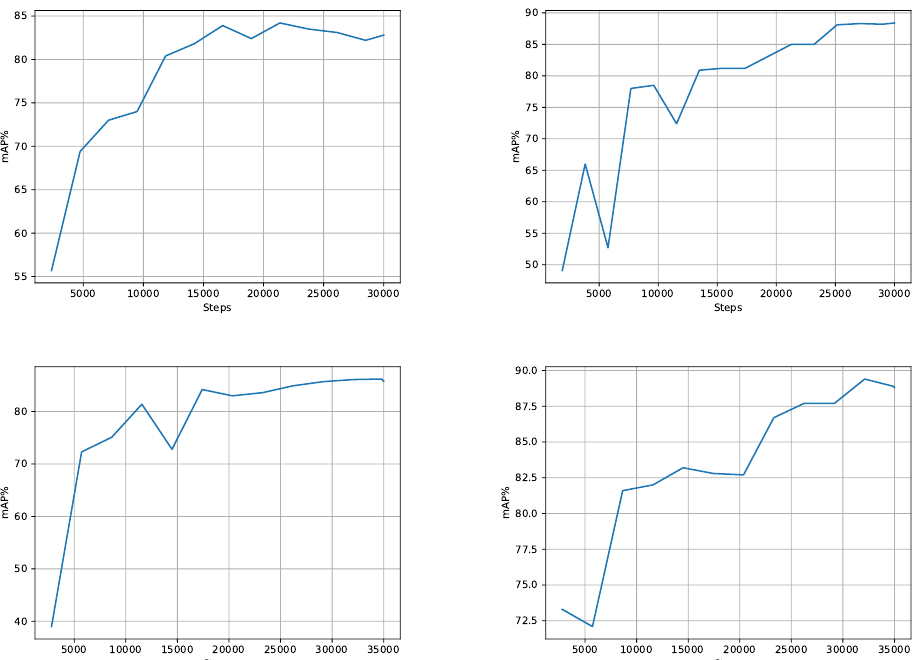
Figure 9. mAP of models during training (threshold = 50). Top left: MobileNet-V1, top right: MobileNet-V2, bottom left: MobileNet Edge TPU and bottom right: MobileDet Edge TPU.